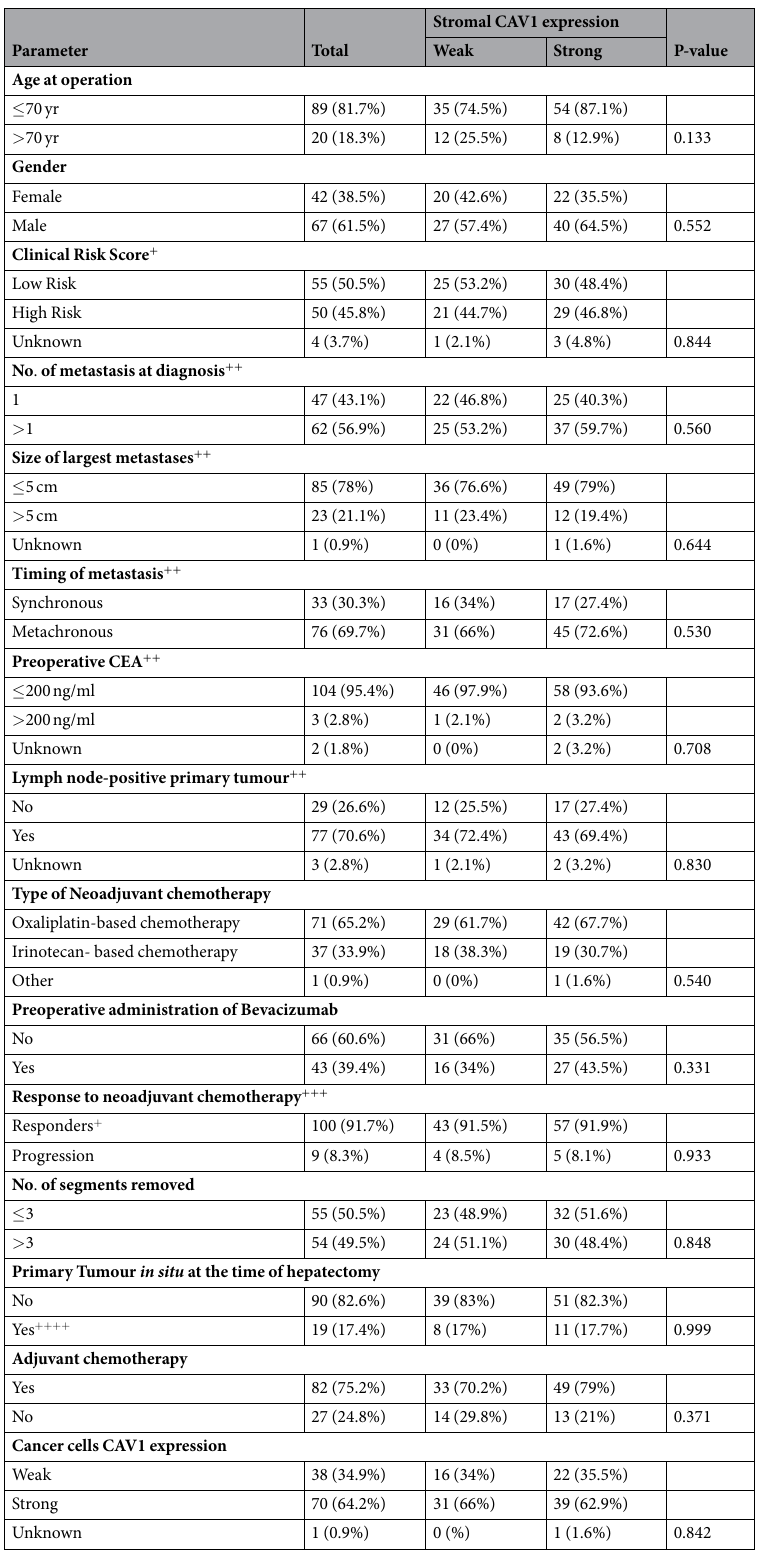
Table 1. Relationships between baseline clinicopathologic characteristics and Stromal CAV1 expression. + Clinical Risk Score according to Fong Y et al . 5 . ++ Clinical Variables included in the Clinical Risk Score 5 . +++ Radiologic Complete Response or Radiologic Partial Response or Stable Disease (according to RECIST) 16 . ++++ 15 patients underwent synchronous resection of primary tumour and CRLM and 4 patient were management with ‘liver first’